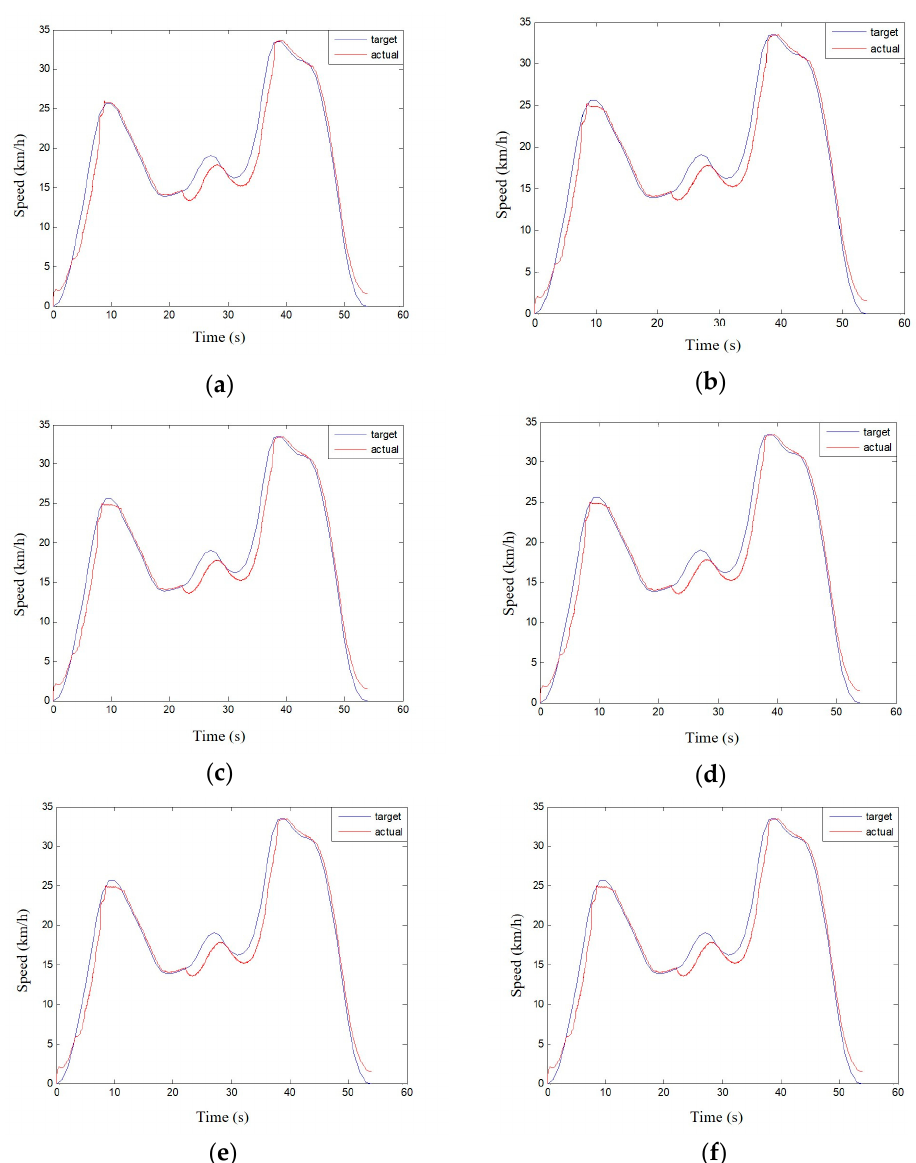
for different motors under working condition B.